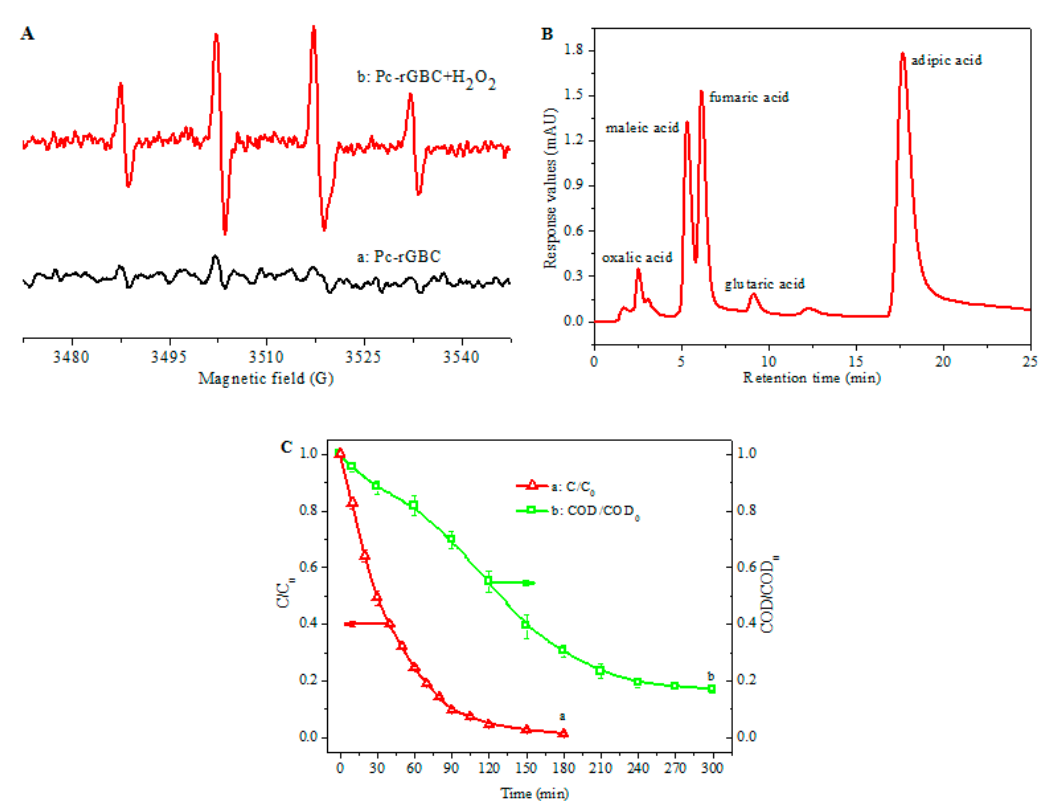
Figure 7. ( A ): Electron paramagnetic resonance (EPR) spectra of phenol solution in the presence of a: Pc-rGBC and b: Pc-rGBC+H 2 O 2 . ( B ): HPLC of the products of the catalytic oxidation of phenol with the catalytic reaction system. ( C ): Concentration and COD changes in the phenol solution in the catalytic oxidation of phenol by Pc-rGBC+H 2 O 2 .